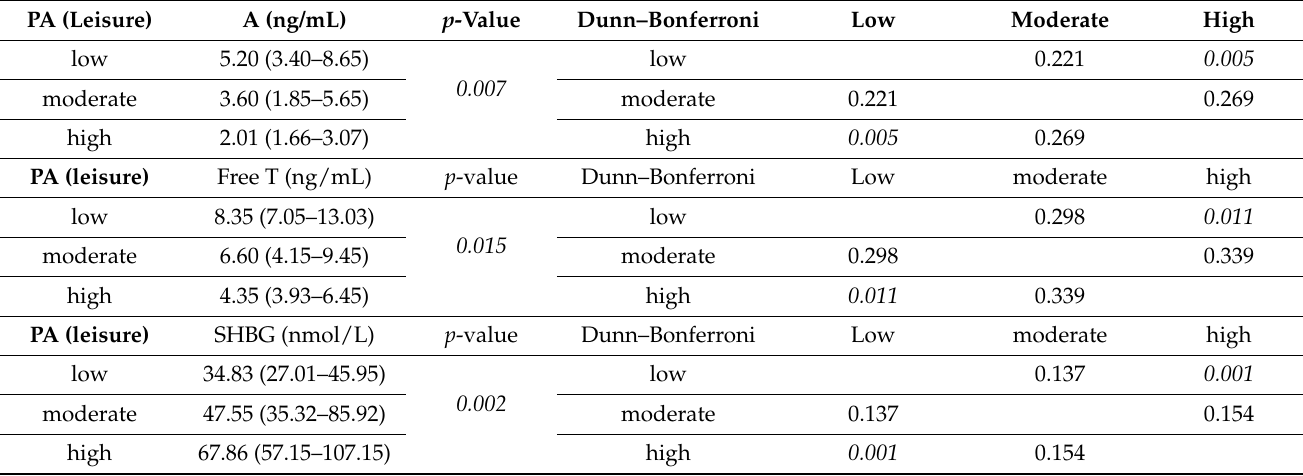
Table 5. Comparison of the serum concentrations of A, fT and SHBG depending on the level of PA (PCOS group).